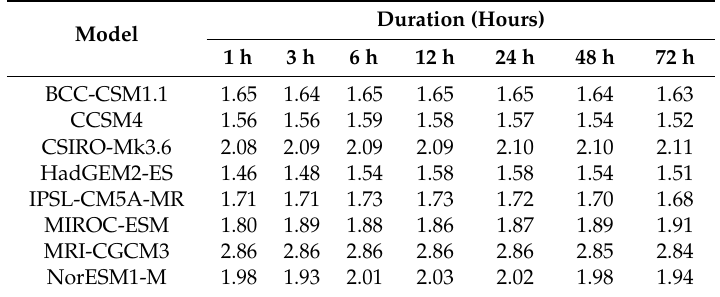
Table 9. Model Correction Factors (MCFs) estimated for different GCMs for RCP 4.5 at